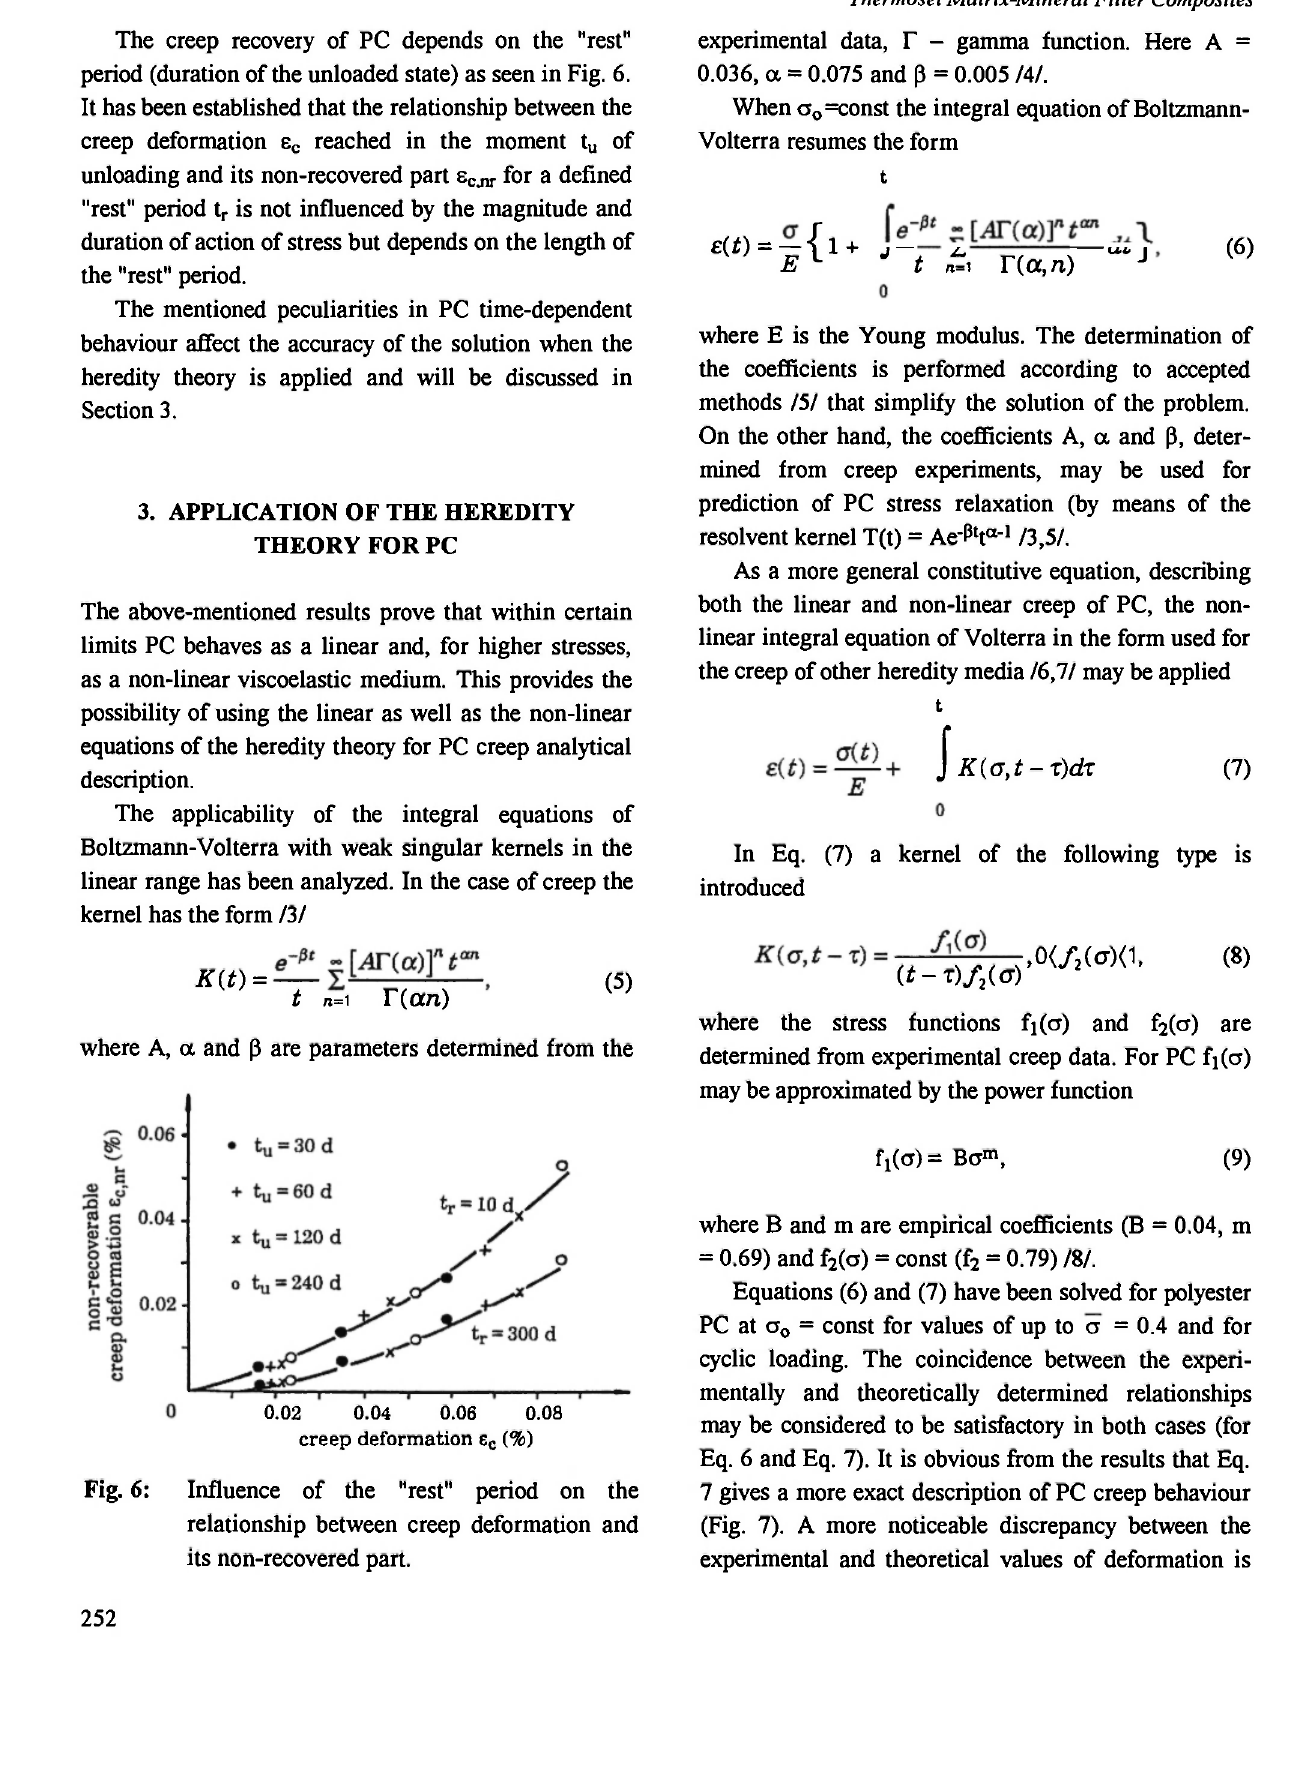
Fig. 6: Influence of the "rest" period on the relationship between creep deformation and its non-recovered